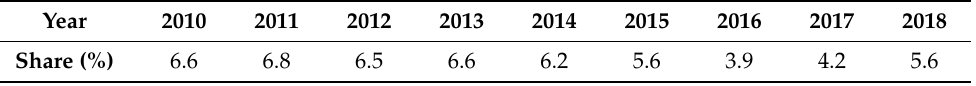
Table 4. Share of renewable energy in Polish transport in 2010–2018